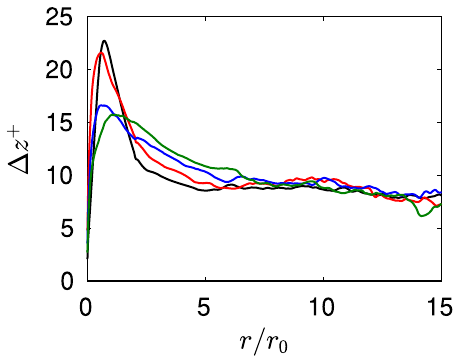
Figure 2. Variations of axial mesh spacing D z for L = 15 r 0 , Figure 3. Variations of the axial mesh spacing D z + on the L = 20 r L = 25 r L = 30 r plate, in wall units, for L = 15 r 0 , L = 20 r 0 , L = 25 r 0 0 , 0 and 0 . and L = 30 r 0